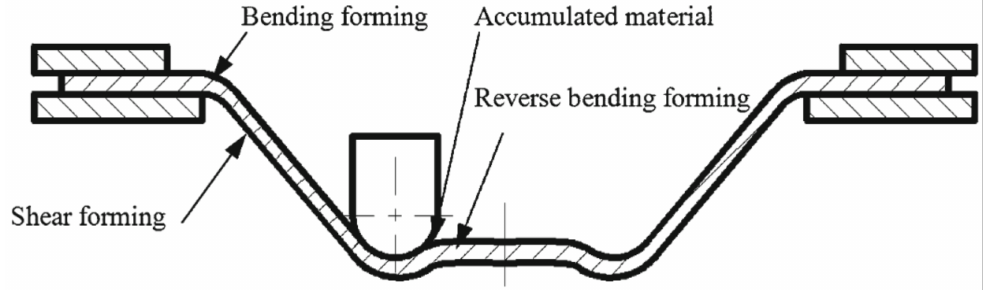
Figure 9. Forming regions in a SPIFed component (reprinted with permission from [93]; copyright © 2014, Springer-Verlag